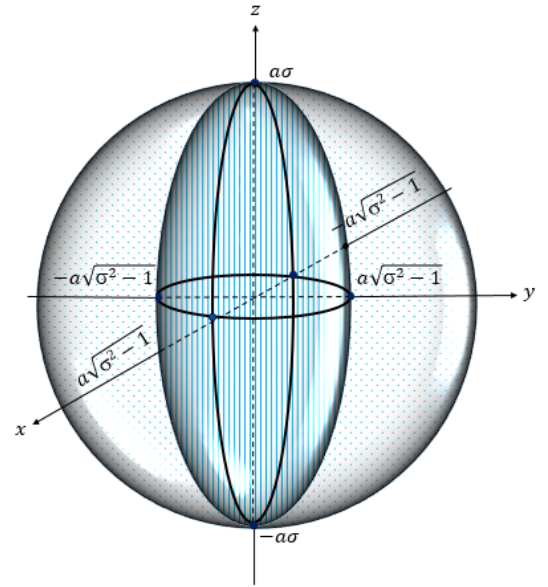
Figure 1. Special curvilinear coordinates σ , τ , and ϕ of the prolate